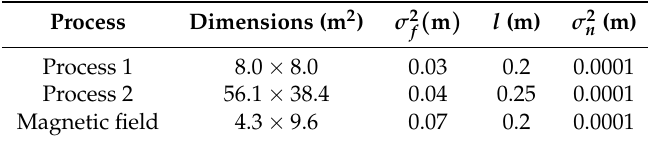
Table 2. Explored GP process y with hyper-parameters θ